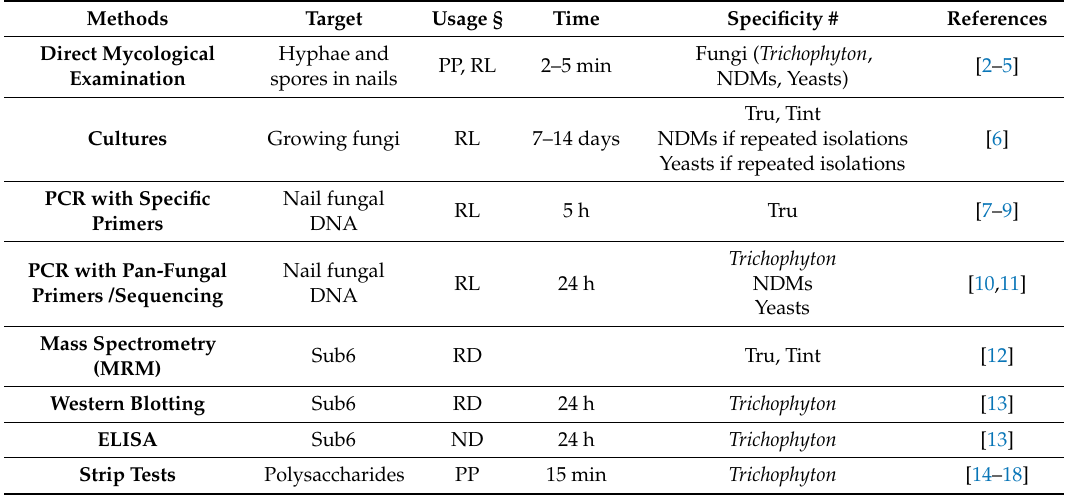
Table 1. Tools for the diagnosis of onychomycosis and rapid identification of the pathogen.